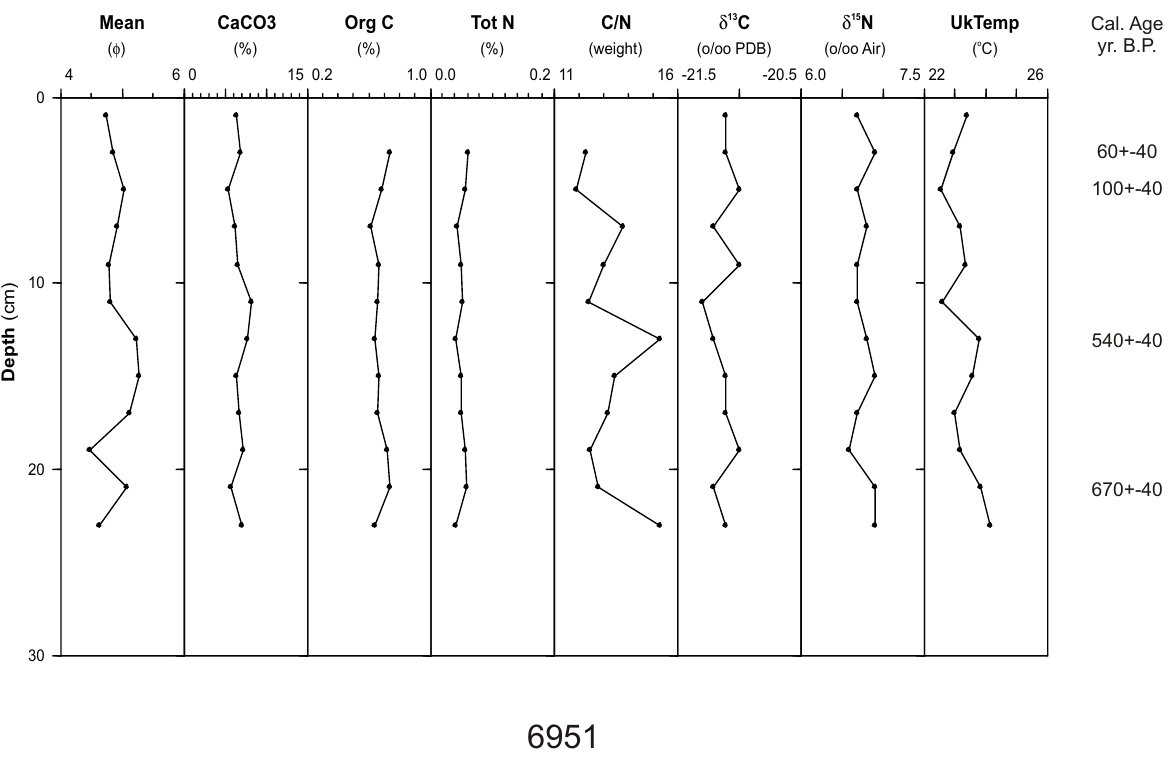
Fig. 4 – Mean grain-size, compositional, isotopic, and paleotemperature variations along core 6951.